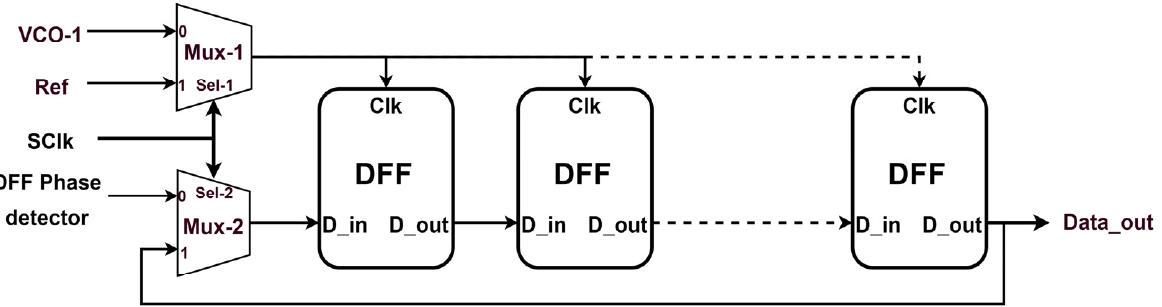
Figure 8. Implementation of the LUT.